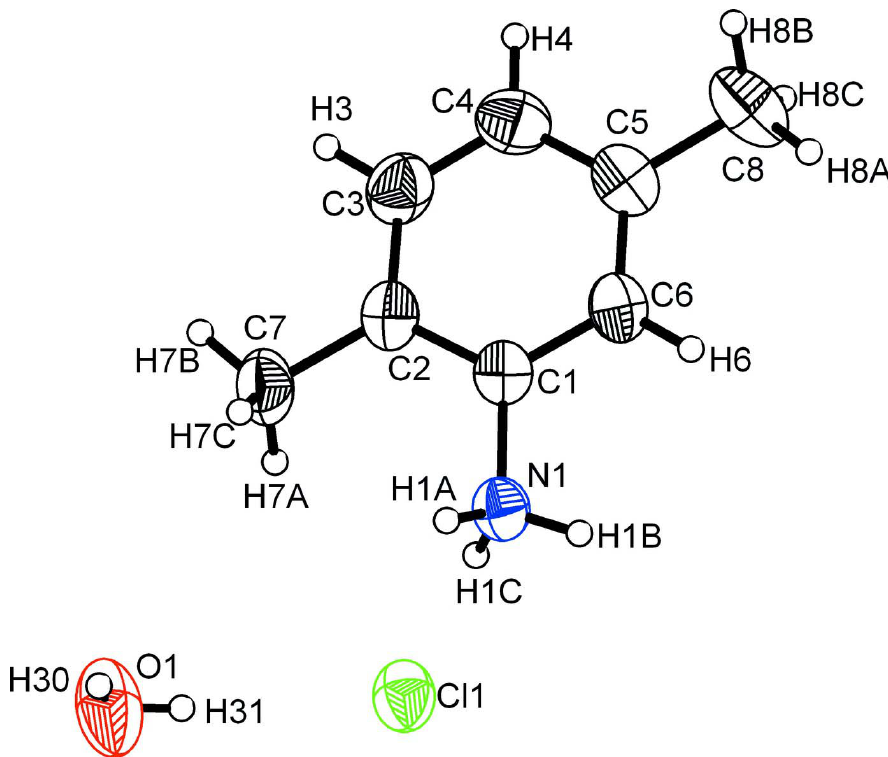
Figure 1 View of (I) with displacement ellipsoids for non-H atoms drawn at the 30% probability